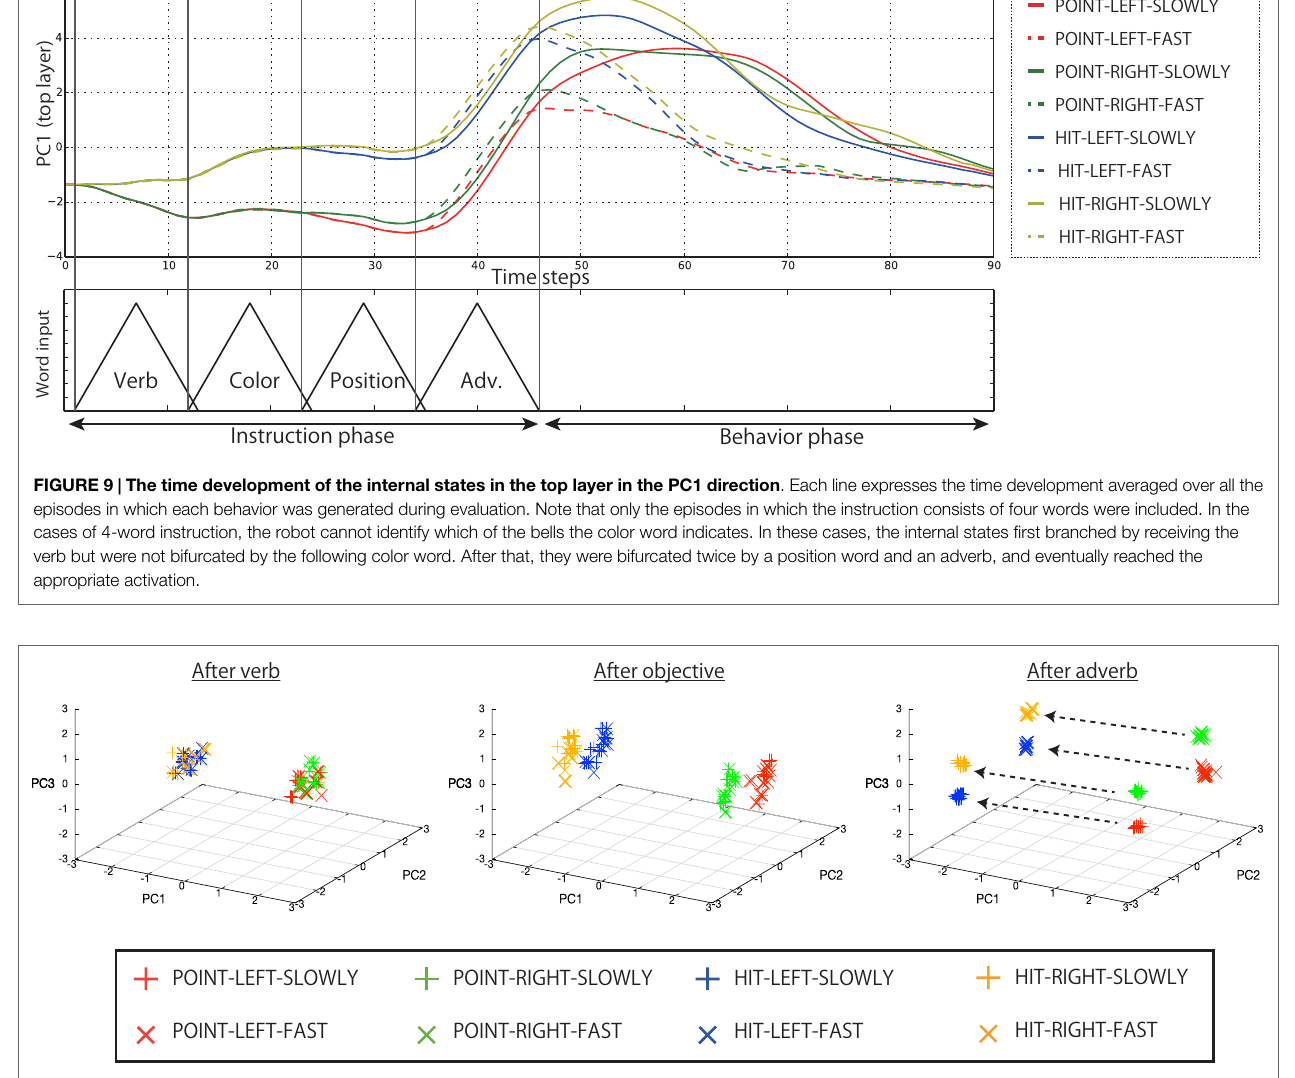
was 0.972, indicating that they are almost parallel. In the cases of the LEFT-RIGHT axis and the SLOWLY-FAST axis, the minimum cosines are 0.938 and 0.977, respectively. In contrast, the cosines (1) between the POINT-HIT axis and the LEFT-RIGHT axis, (2) between the POINT-HIT axis and the SLOWLY-FAST axis, and (3) between the LEFT-RIGHT axis and the SLOWLY-FAST axis were 0.079, 0.075, and 0.035, respectively, indicating that these axes are almost orthogonal. This parallelepiped was developed